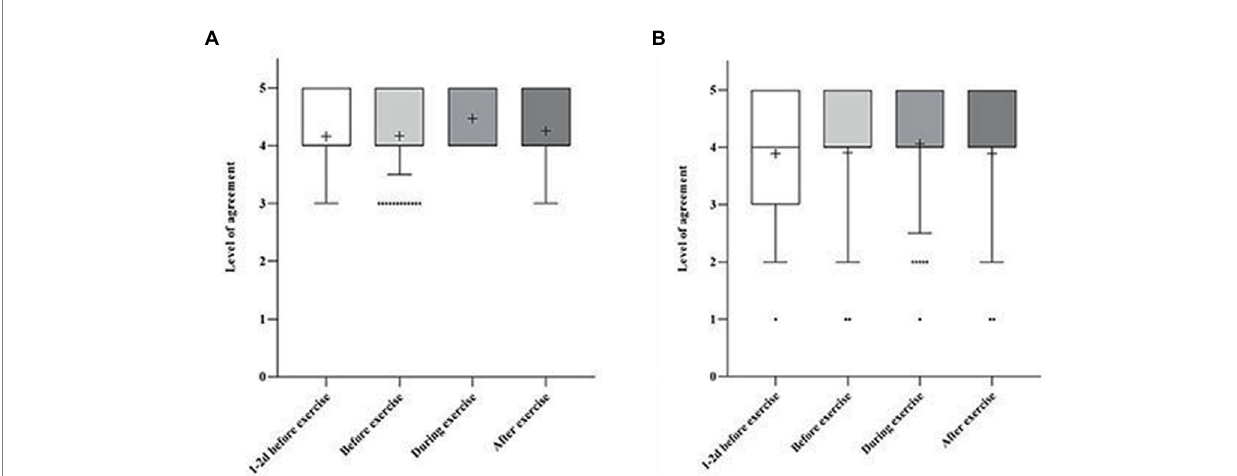
FIGURE 1 Box and whisker chart showing the median and 10–90th percentile range for endurance athletes with ( n = 137) and without ( n = 64) exercise-associated gastrointestinal symptoms (Ex-GIS) and their beliefs about consuming carbohydrates before, during, and after exercise in relation to enhancing athletic performance (i.e., timing of carbohydrate consumption). Data violates homogeneity of variances and is not normally distributed. Outliers are included to show variation in responses. Athletes’ beliefs about consuming carbohydrates to enhance performance are measured by the athlete’s level of agreement with each statement using a Likert scale, 1, strongly disagree; 2, disagree; 3, neither agree nor disagree; 4, agree; 5, strongly agree. Timing defined as: 1–2d before exercise = 1–2 days before an event ≥ 90 min; Before exercise = in last meal or snack before endurance training or an event ≥ 90 min; During exercise = during endurance training or an event ≥ 60 min; After exercise = within 30 min after endurance exercise when there is ≤ 8 h between sessions; (A) , athletes with reported Ex-GIS; (B) , athletes without reported Ex-GIS; + mean; •